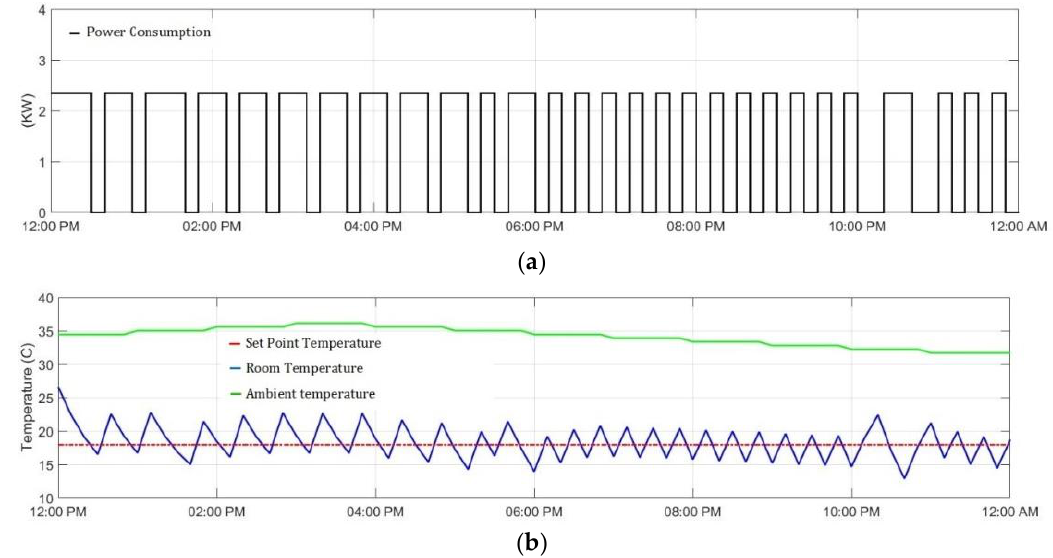
Figure 3. Simulation results of air conditioning (AC) model. ( a ) AC power consumption and ( b ) room temperature versus set point.